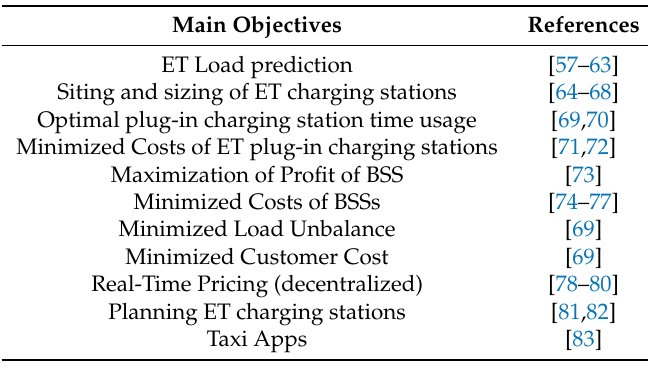
Table 3. Main Objectives of ET-related Papers.